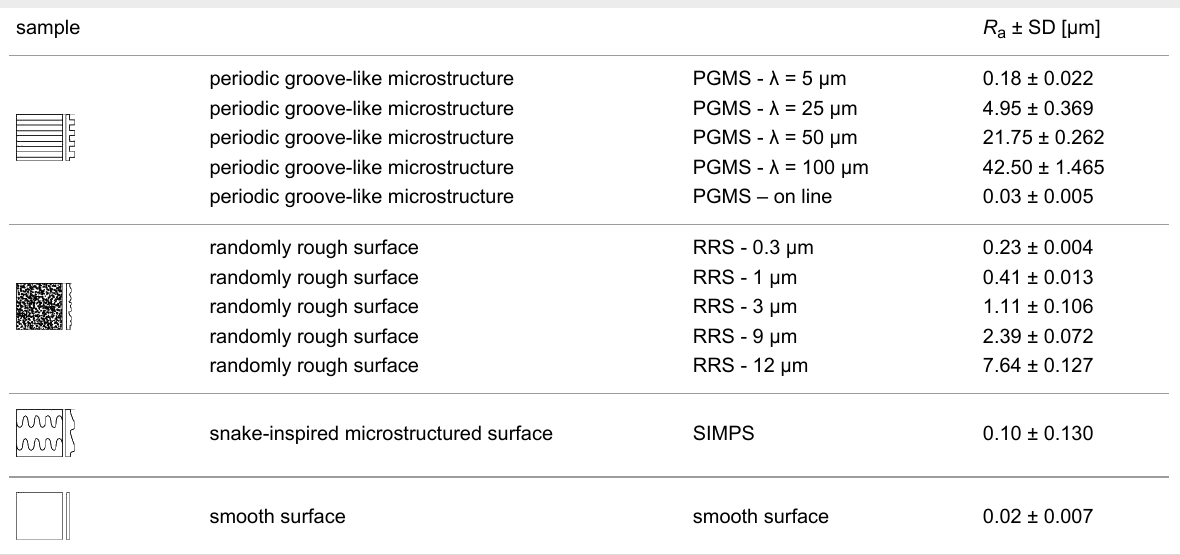
Table 5: Surface roughness ( R a ) of all investigated polymer surfaces. λ : pitch dimension. SD: standard deviation. For PGMS, the surface roughness was measured perpendicular to the microstructure for each type of pitch dimension. In parallel direction to the PGMS microstructures, the roughness was averaged over all pitch